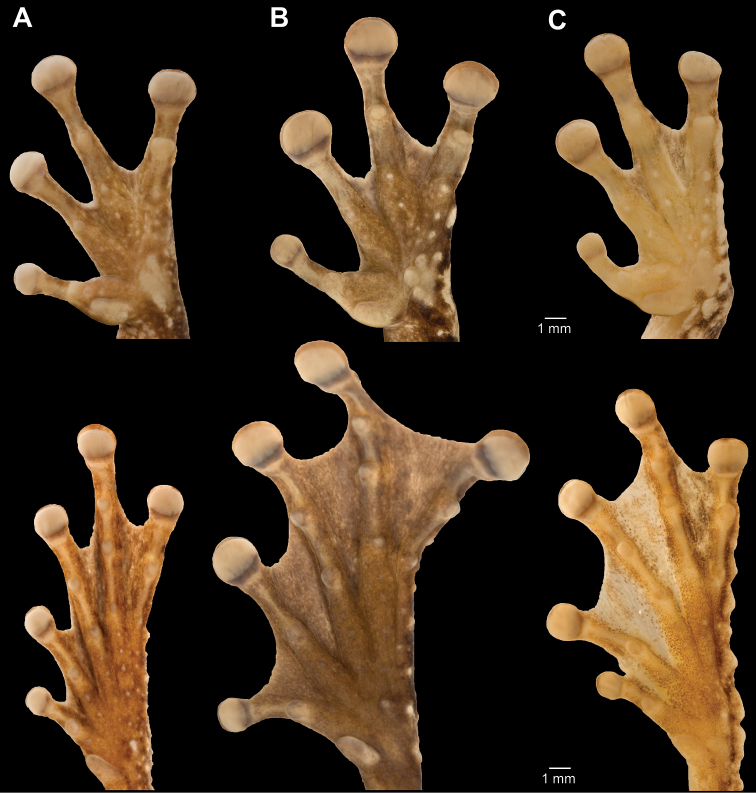
Ventral views of the left hand and foot of Osteocephalus. A
Osteocephalus buckleyi (Tarangaro, Ecuador, SVL = 39.8 mm, QCAZ 39191) B
Osteocephalus cannatellai (Zanjarajuno, Ecuador, SVL = 45.32 mm, QCAZ 45907)and C
Osteocephalus cabrerai (Cuyabeno, Ecuador, SVL = 41.62 mm, EPN-H 7204). Hand and foot are shown at the same scale.